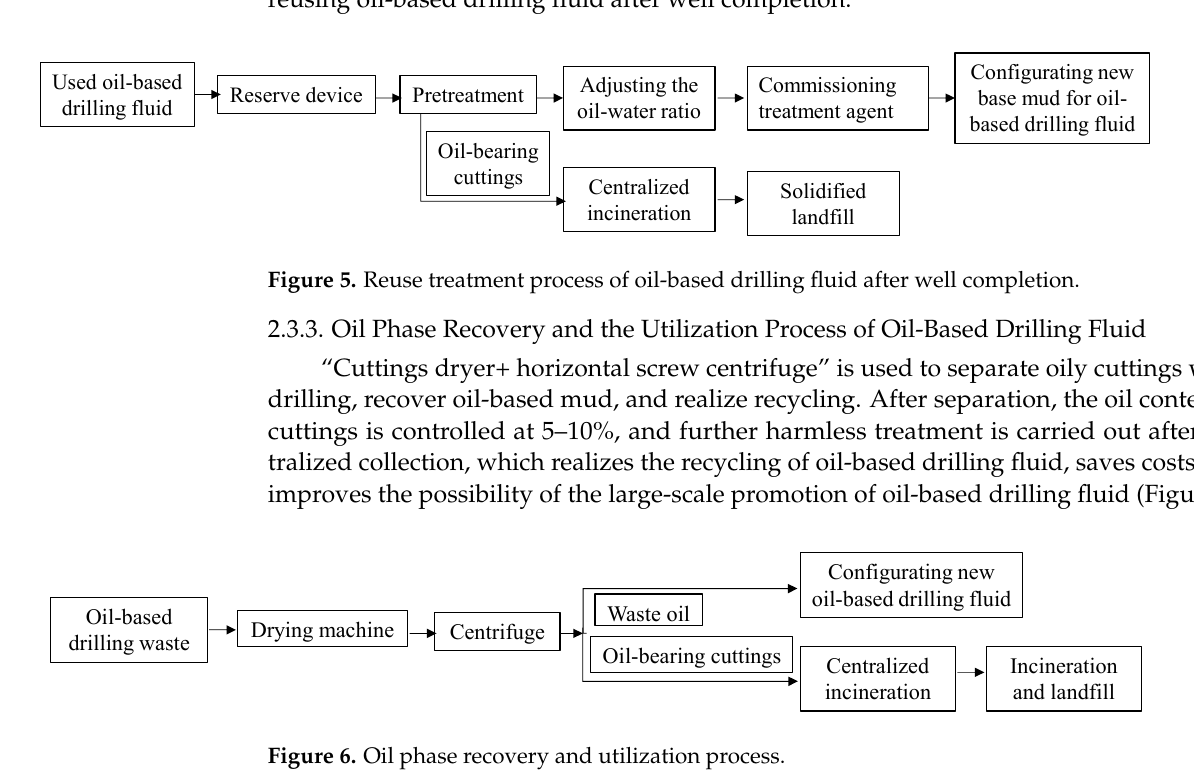
Figure 6. Oil phase recovery and utilization process.